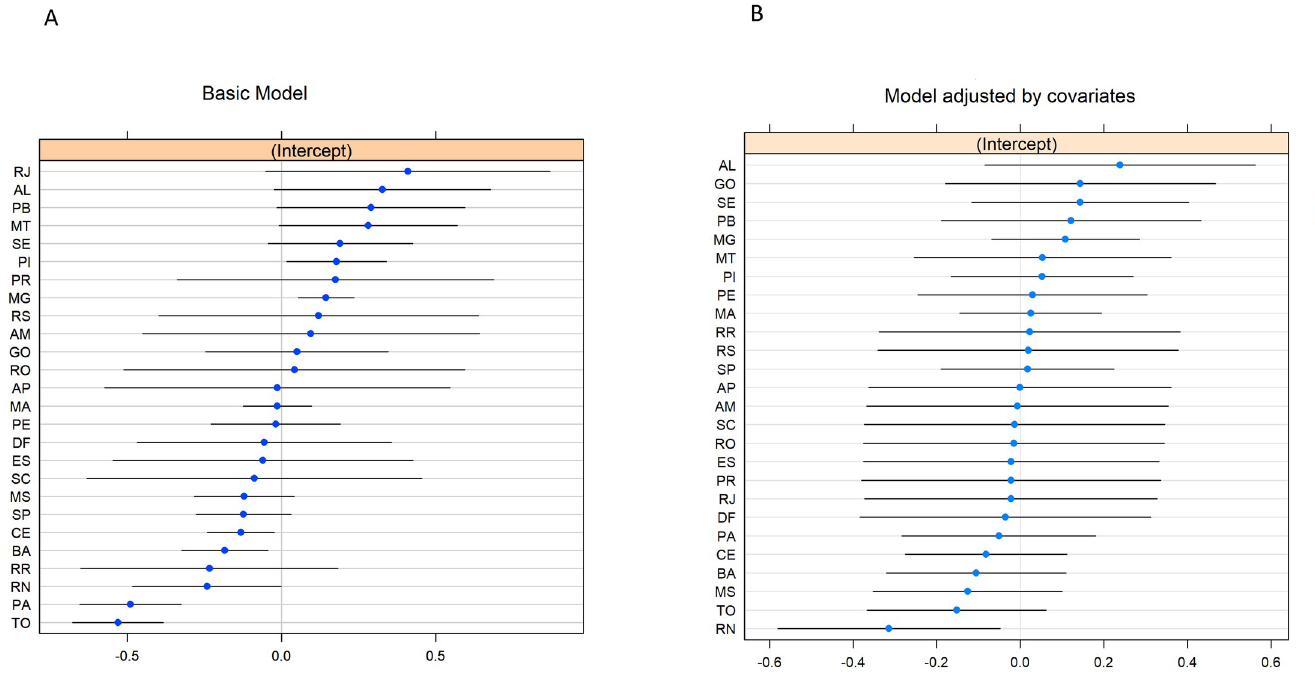
Fig 6. Residual effect of VL case-fatality for each Brazilian FU, according to the basic model (left) and model adjusted by covariates (right).